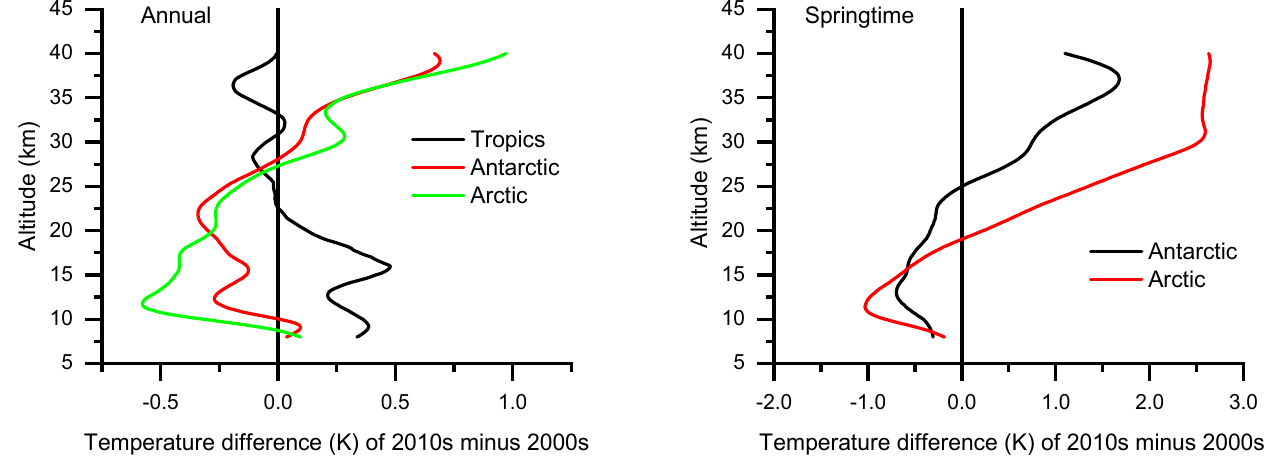
Figure 2. ( a , b ): Altitude profiles of the temperature differences at altitudes of 8–40 km of the 2010s (2010–2020) minus the 2000s (2002–2010) for the annual tropics (30° S–30° N), annual and springtime Antarctic (60°–90° S) and Arctic (60°–90° N).